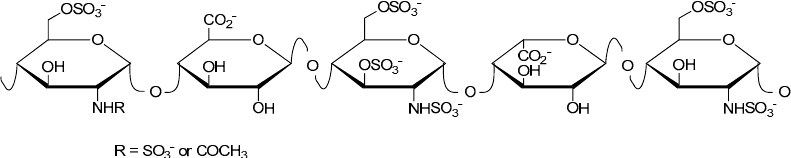
Figure 1. Schematic structure of heparin showing here the antithrombin-binding pentasaccharide sequence.